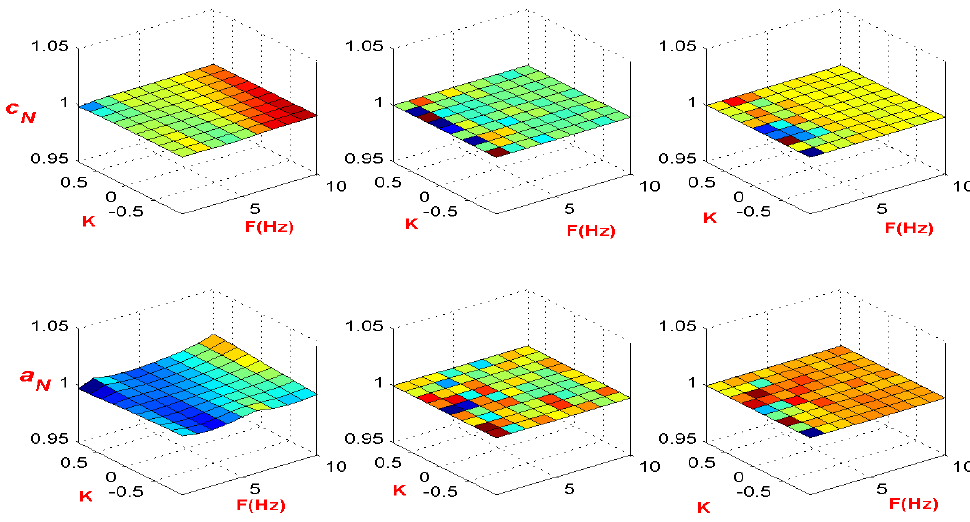
Fig. 2 Three dimensional view of frequency pattern of normalized phase velocity (top panels) and normalized attenuation (bottom panels) for different reflection coefficient ( K 0 = -0.98, -0.78, -0.58, -0.38, -0.18, 0.02, 0.22, 0.42, 0.62 and 0.82 ). The panels in the left column show data from RV-I method, the panels in the central column show data from RV-II method, and the panels in the right column show data from three-point method. L =44.3cm , d=5cm, R 0 =2.9 mm, (cid:2242) (cid:2777) = (cid:2778)(cid:2779) (cid:2197) , E 0 =8.21 10 5 Pa, (cid:2246) = 2.53 10 -3 Pa.s.